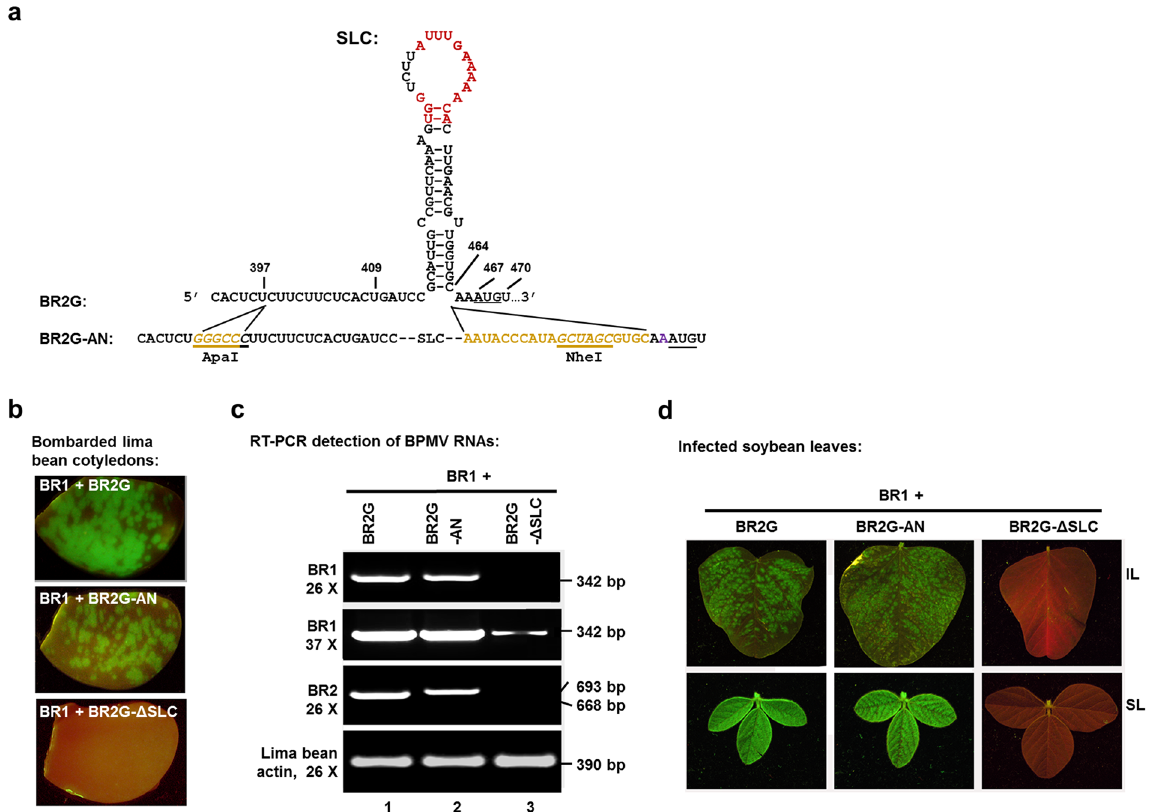
Figure 2. A BR2G derivative (BR2G-AN) that permits the manipulation of SLC sequence. ( a ) The sequence and structure of SLC and its vicinity, and modifications introduced to produce BR2G-AN. Specifically, five nts (GGGCC, in brown letters) were inserted between nt no. 397 and 398 to yield a new ApaI site (italic, underlined). Additionally, 20 extra nts (in brown letters) were inserted between nt no. 464 and 465 that also introduce a new NheI site (italic, underlined). Note that the first two of the 20 nts are identical to those immediately downstream of SLC in original RNA2 sequence, whereas the last four are duplicates of the last four stem nts. ( b ) Lima bean cotyledons bombarded with the construct mixes shown. ( c ) RT-PCR detection of both BR1 and BR2 RNAs in bombarded lima bean cotyledons. A 390-bp fragment of the lima bean actin mRNA was used as a control to ensure similar amounts of RNA were used in all reactions. ( d ) inoculated and systemically infected leaves of soybean plants (IL and SL) showing nearly identical infection efficiencies of BR2G and